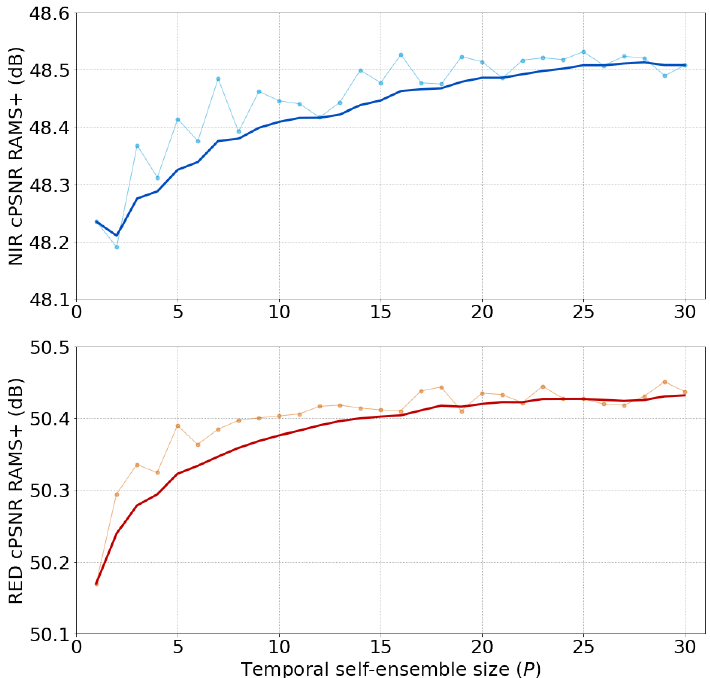
Figure 4. Results with a temporal self-ensemble of size P . The highlighted curves represent an exponential moving average of the results to clearly show the trend. The values for P = 1 are equivalent to